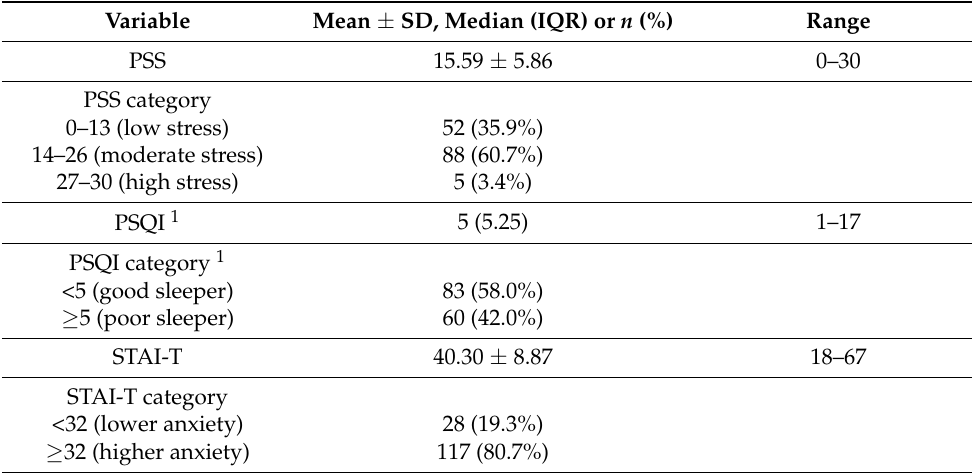
Table 2. Subjective stress, anxiety and sleep quality indicators of the study